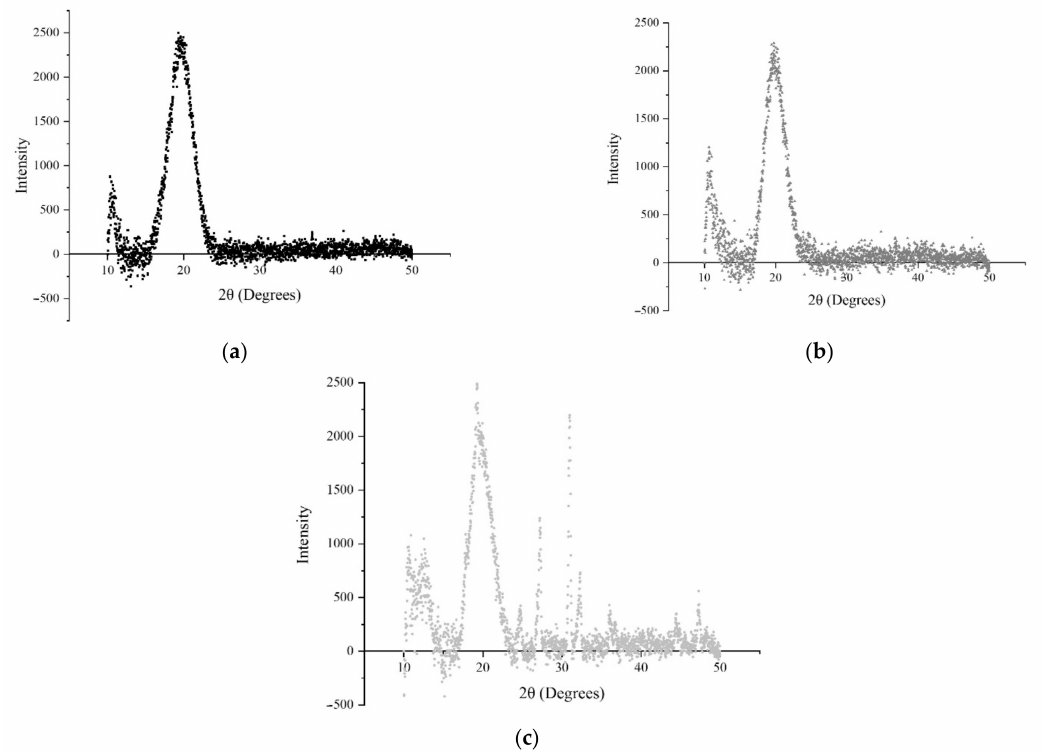
Figure 4. X-ray diffraction of OEO-loaded (1%) nano-emulsions ( a ) NE I, ( b ) NE II, and ( c ) NE